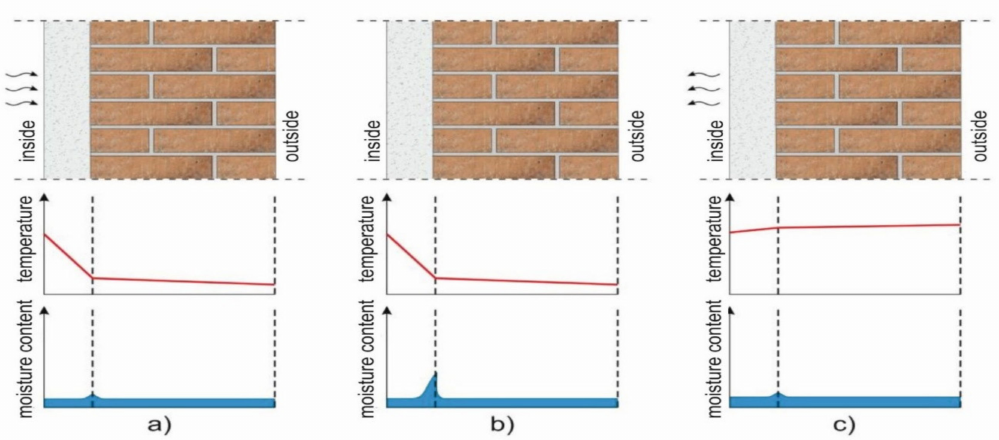
Figure 3. General principle of the functioning of partitions insulated from the inside using aerated concrete panels. ( a ) Late autumn period, ( b ) transition from winter to spring, condensation of water vapour inside the partition, ( c ) spring / summer, the partition becomes dry